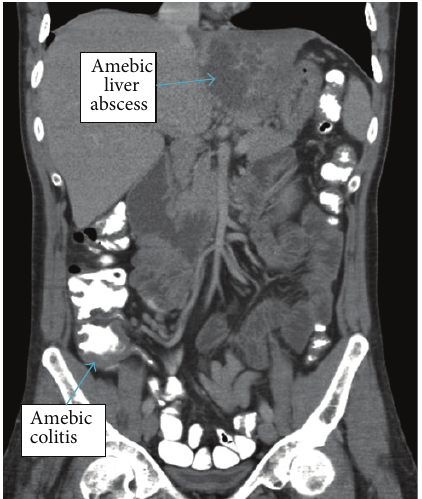
tachypnea of 25 breaths per minute. Physical examination